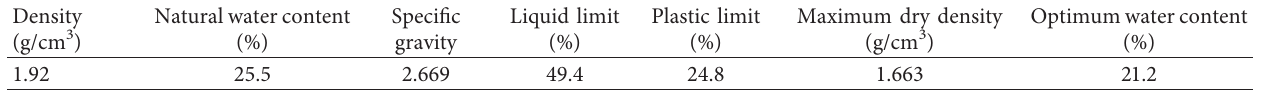
Table 1: Basic physical properties of the tested soil.